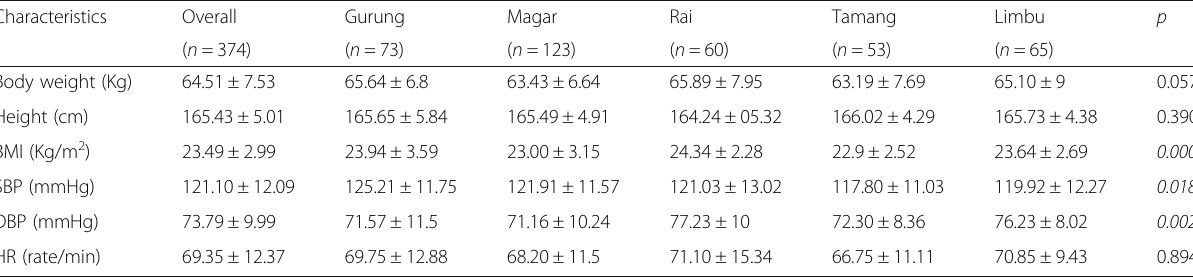
Table 3 Physiological characteristics of the male Gorkha soldiers (TB) ( n = 374)